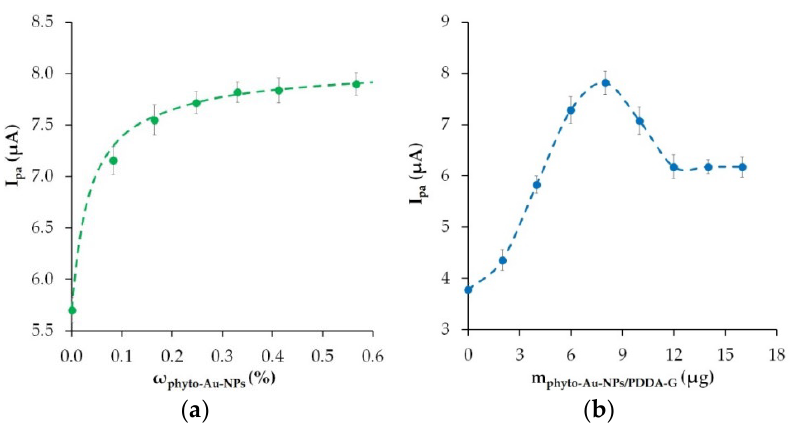
Figure 7. The effects of phyto-AuNP mass content in nanocomposite ( a ) and phyto-AuNPs/PDDA-G quantity in sensing material ( b ) on 10 μM Ponceau 4R signal.